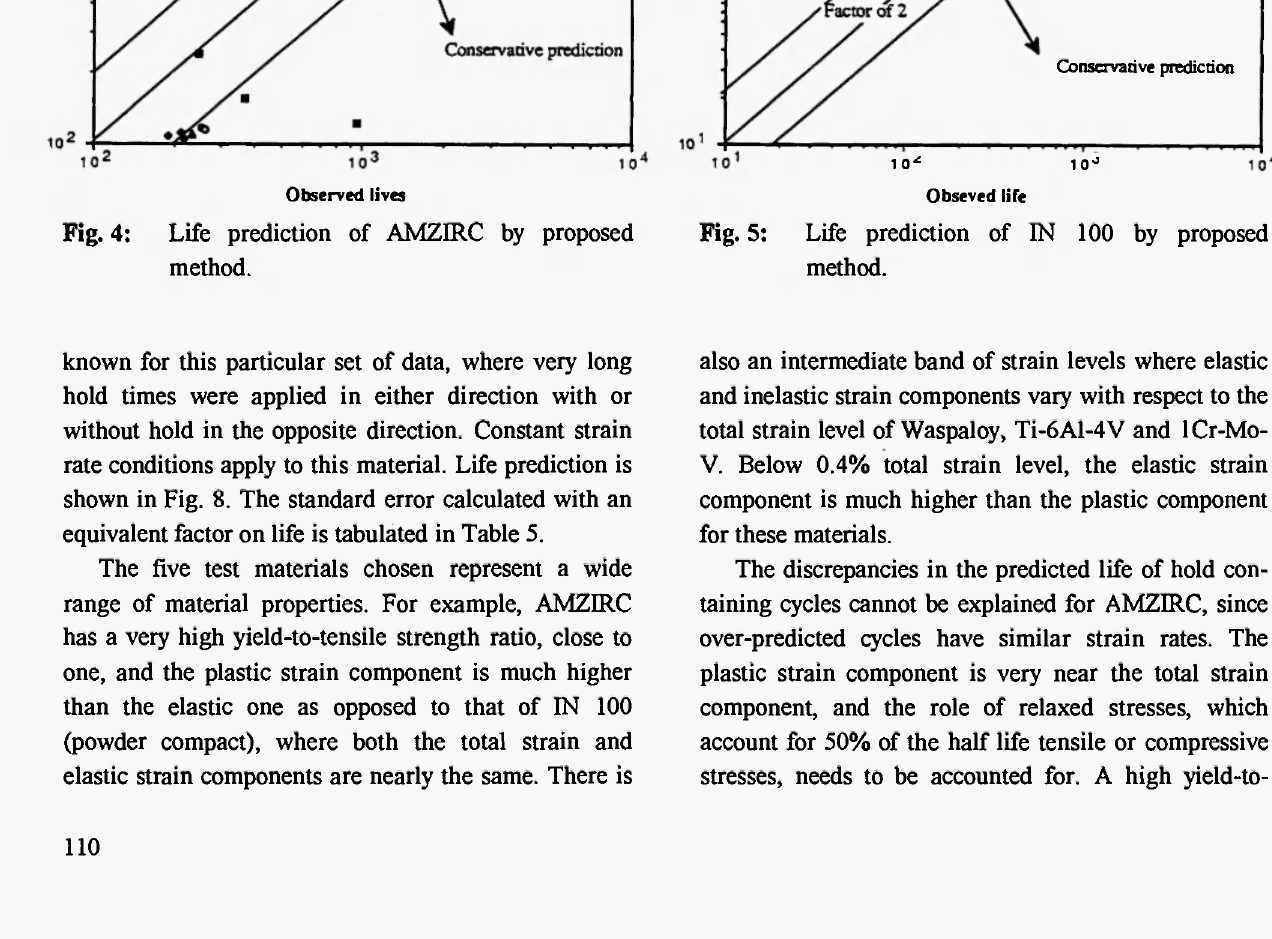
Fig. 5: Life prediction of IN 100 by proposed